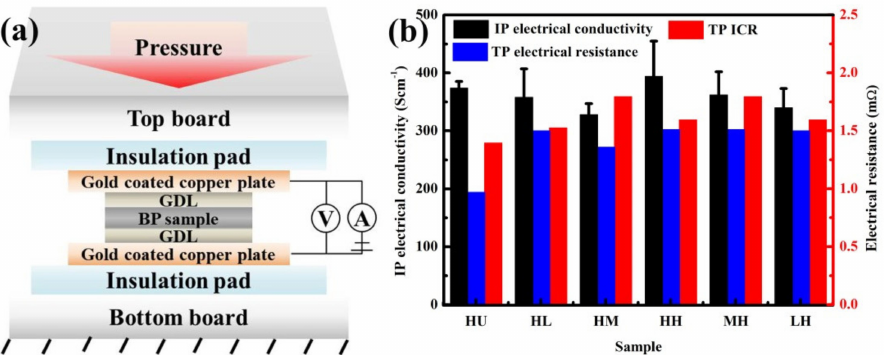
Figure 7. Electrical properties. ( a ) Illustration on TP electrical resistance and overall Interfacial Contact Resistance (ICR) test, and ( b ) IP electrical conductivity, TP electrical resistance, and overall ICR of composite